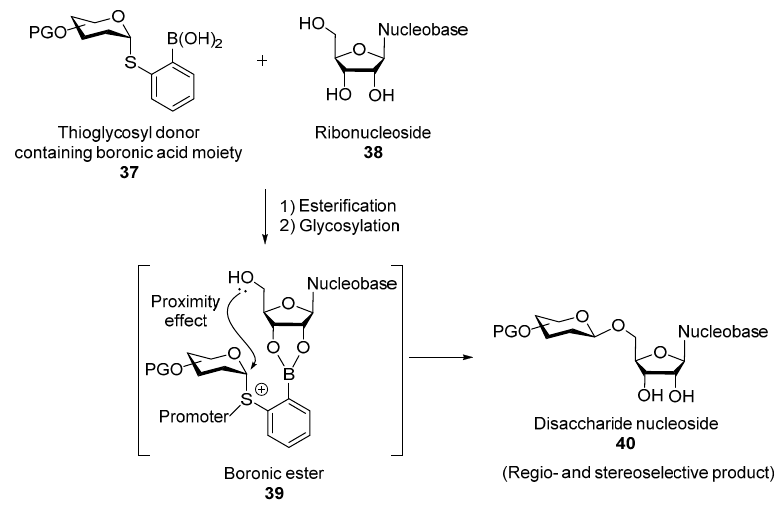
Figure 2. Regio- and stereo-selective O -glycosylation of the ribonucleoside utilizing the glycosyl donor containing a boronic acid moiety.